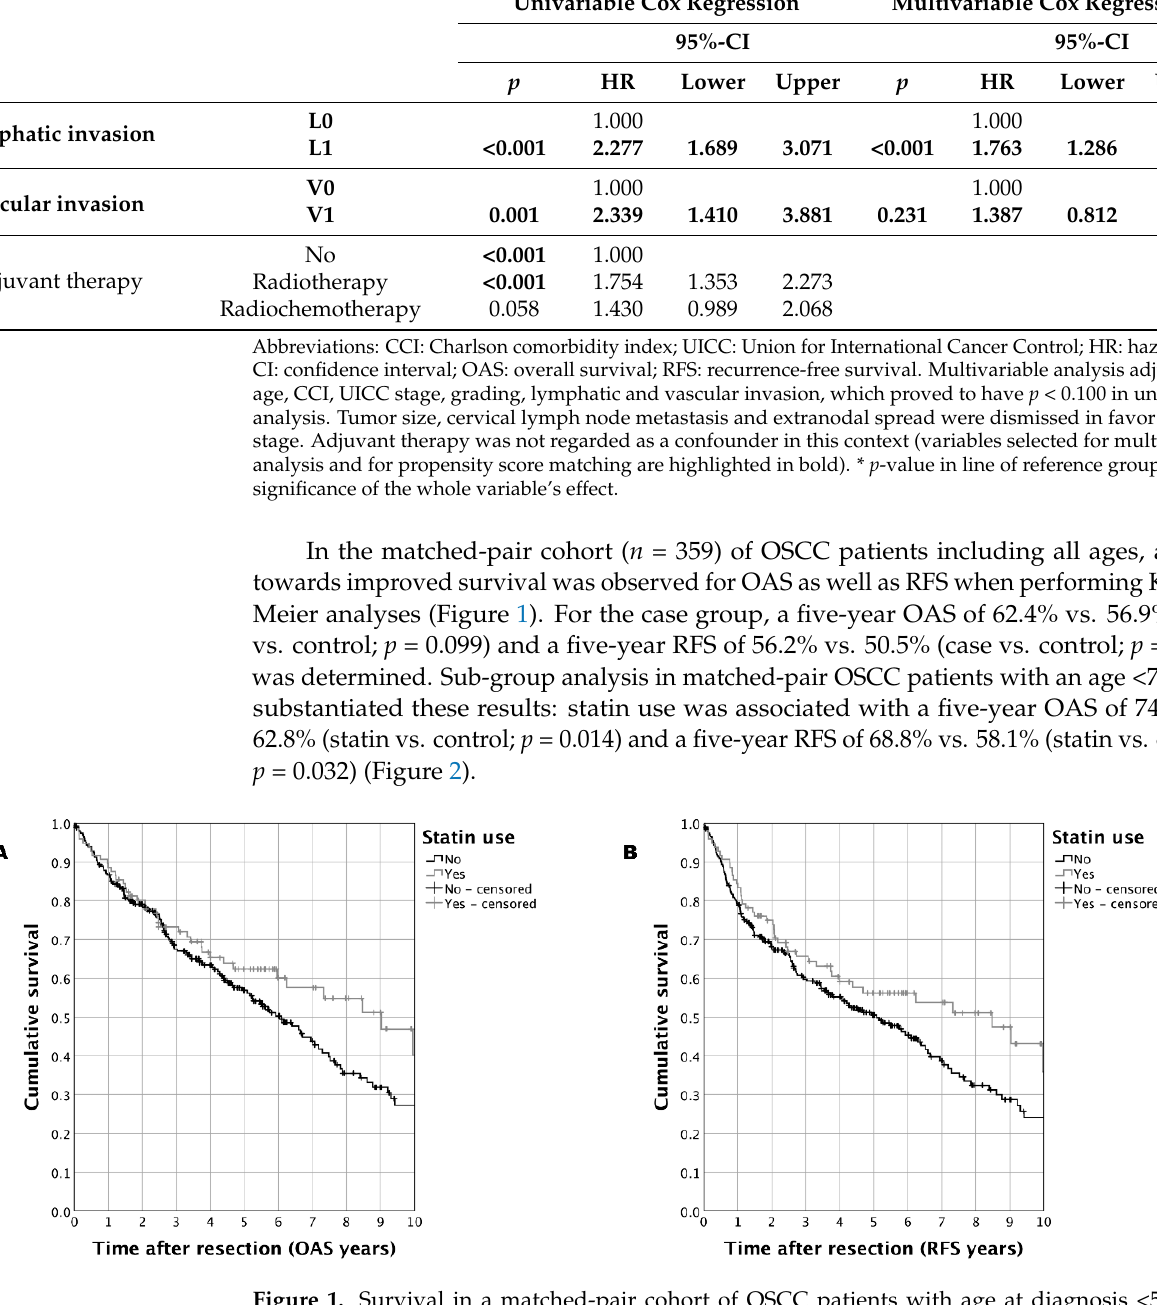
Figure 2. Survival in a matched-pair cohort of OSCC patients with age at diagnosis <70 years ( n = 246) comparing patients taking statins at the time of diagnosis compared to those patients without statin treatment: ( A ): Kaplan–Meier analysis for OAS ( p = 0.014); ( B ): Kaplan–Meier analysis for RFS ( p = 0.032). In univariable Cox regression analysis, statin use was not significantly correlated with OAS (HR 0.869; 95% CI 0.619–1.220, p = 0.418) as well as RFS (HR 0.839; 95% CI 0.610– 1.155, p = 0.282) in the complete OSCC cohort comprising all ages (no PSM applied). How- ever, in the complete cohort of OSCC patients <70 years ( n = 459, no PSM applied) an improved OAS (HR 0.595; 95% CI 0.370–0.956, p = 0.032) as well as RFS (HR 0.656; 95% CI 0.429–1.003, p = 0.052) was observed. In the matched-pair cohort of patients <70 years re- vealed an even more pronounced effect for OAS (HR 0.537; 95% CI 0.325–0.887, p = 0.015) and RFS (HR 0.613; 95% CI 0.390–0.964, p = 0.034). Data from multivariable Cox regression regarding statin use and oncological param- eters in OSCC patients are mentioned in Table 3: Routine statin intake was significantly correlated with ameliorated OAS and RFS in the unmatched OSCC cohort (OAS: HR 0.664; 95% CI 0.467–0.945, p = 0.023; RFS: HR 0.662; 95% CI 0.476–0.920, p = 0.014) as well as in the entire propensity score-matched OSCC cohort (OAS: HR 0.691; 95% CI 0.479–0.997, p = 0.048; RFS: HR 0.694; 95% CI 0.489–0.976, p = 0.036). In line with the results of univariable survival analysis, statin use in propensity score-matched patients below 70 years was sig- nificantly and even stronger associated with ameliorated survival (OAS: HR 0.461; 95% CI 0.275–0.774, p = 0.003; RFS: HR 0.530; 95% CI 0.333–0.841, p = 0.007).